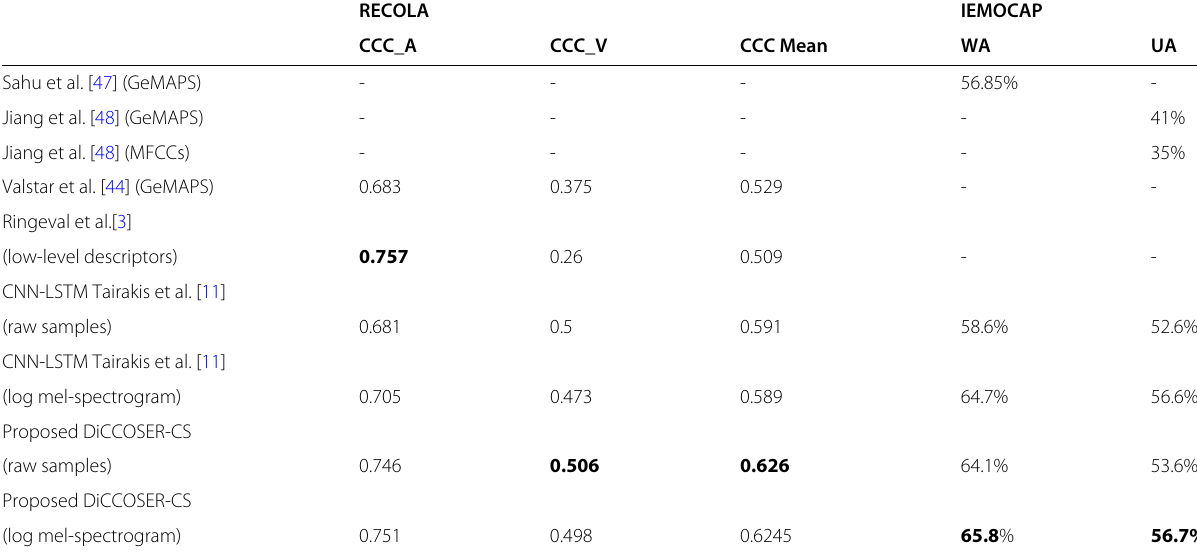
Table 4 Performance comparisons to SER models trained using traditional audio features; best performances are in